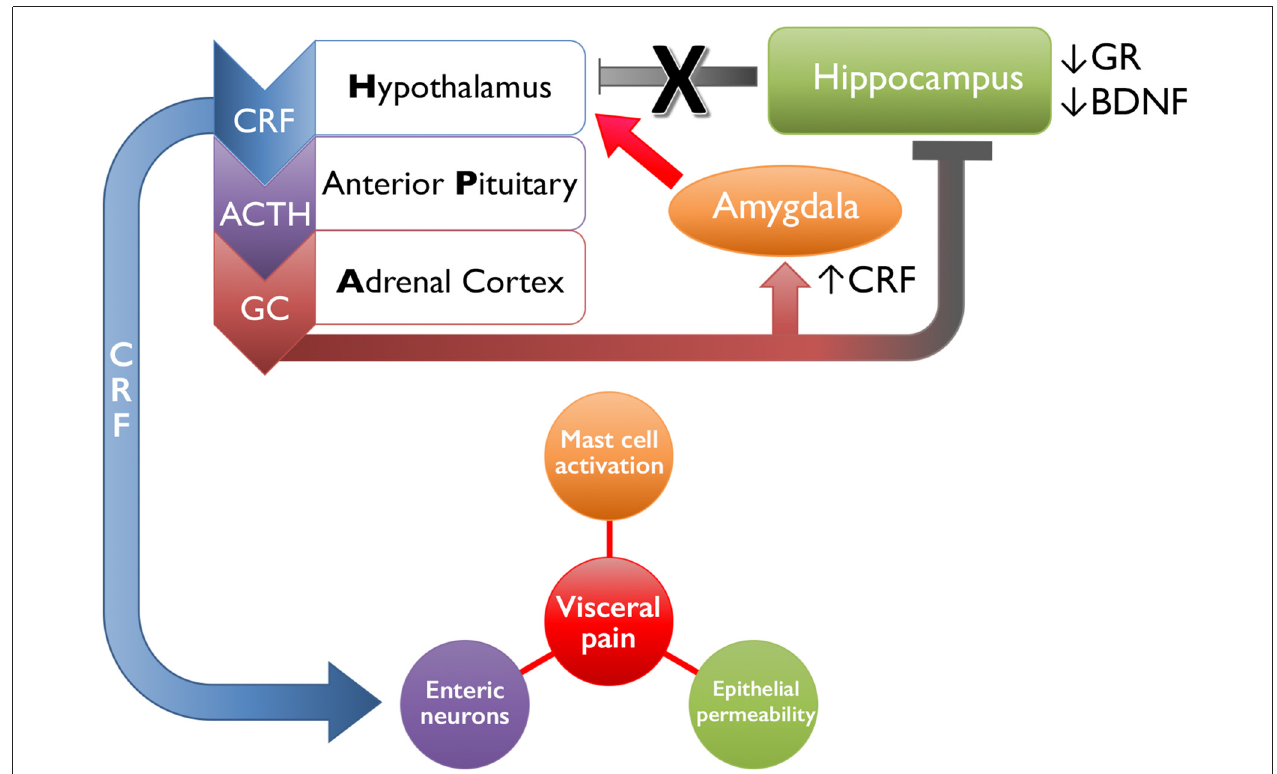
FIGURE 1 | Schematic representation of early life stress-induced changes in limbic regulation of and downstream targets of the hypothalamic-pituitary-adrenal (HPA) axis. Following exposure to an acute stressor, the hypothalamus will release corticotropin-releasing factor (CRF), which signals the anterior pituitary to release adrenocorticotropic hormone (ACTH). The systemic circulation of ACTH initiates the adrenal cortex to release glucocorticoids (GCs, cortisol in humans, corticosterone in rodents). Both GC and CRF will bind to receptors expressed by higher structures within the HPA axis and by limbic structures, including the amygdala and hippocampus, to reduce HPA axis activity and restore homeostasis upon cessation of the stressor. Early life stress disrupts this system by increasing the release of CRF from the hypothalamus and amygdala, as well as decreasing glucocorticoid receptor (GR) and brain-derived neurotrophic factor (BDNF) in the hippocampus, which has a combined effect of increasing positive feedback onto the HPA axis and driving activation. Downstream actions of CRF include increasing mast cell activation and inducing local inflammatory effects, binding onto enteric neurons that can increase colonic motility, and increasing epithelial permeability by disrupting tight junctions. Together these mechanisms drive increased visceral pain in organs affected in irritable bowel syndrome (IBS), interstitial cystitis/painful bladder syndrome (IC/PBS), chronic prostatitis/chronic pelvic pain syndrome (CP/CPPS), and/or